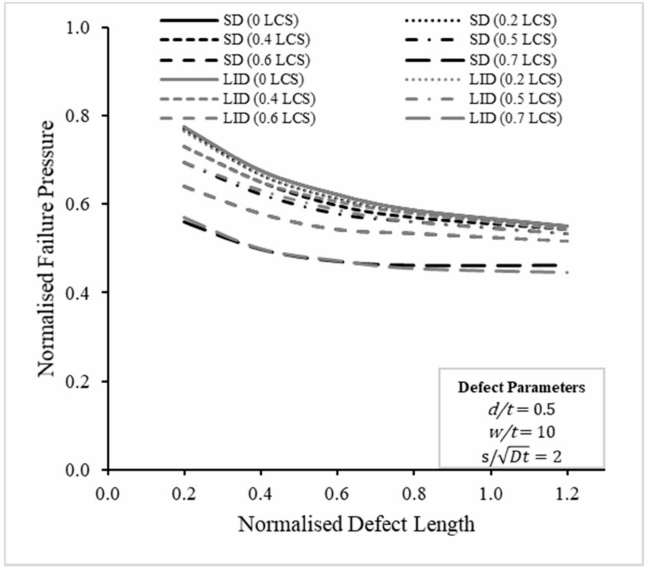
Figure 11. SD and LID comparison of normalised failure pressure predictions versus normalised longitudinal defect spacing across different longitudinal compressive stresses for defect spacing of